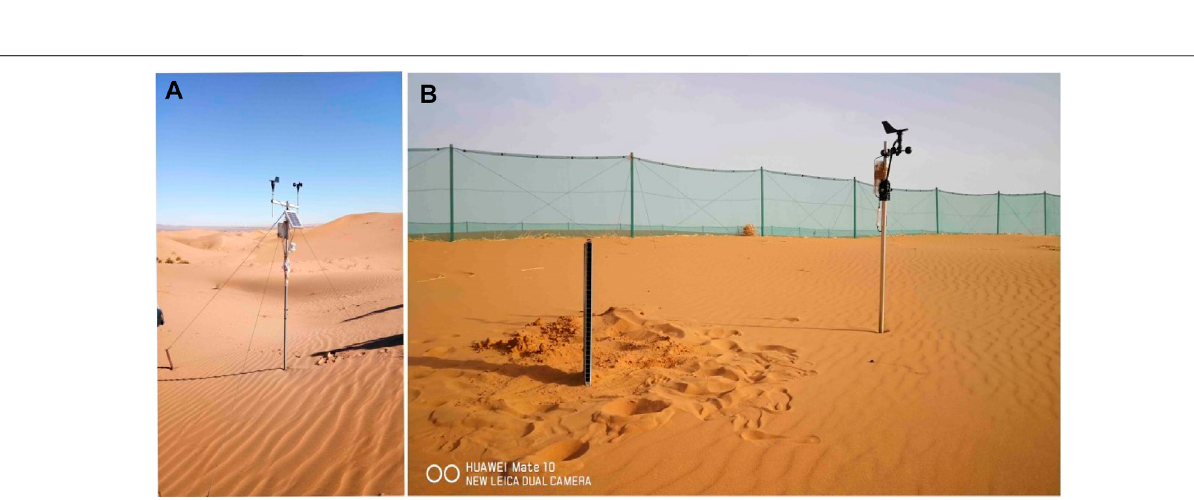
Frontiers in Environmental Science |